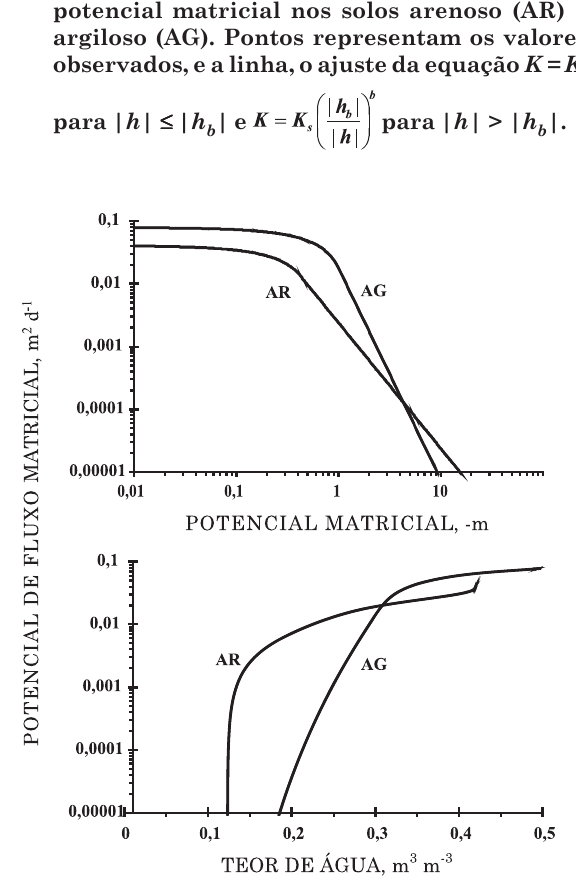
Figura 5. Potencial de fluxo matricial em função do potencial matricial e do teor de água nos solos arenoso (AR) e argiloso (AG) utilizados no